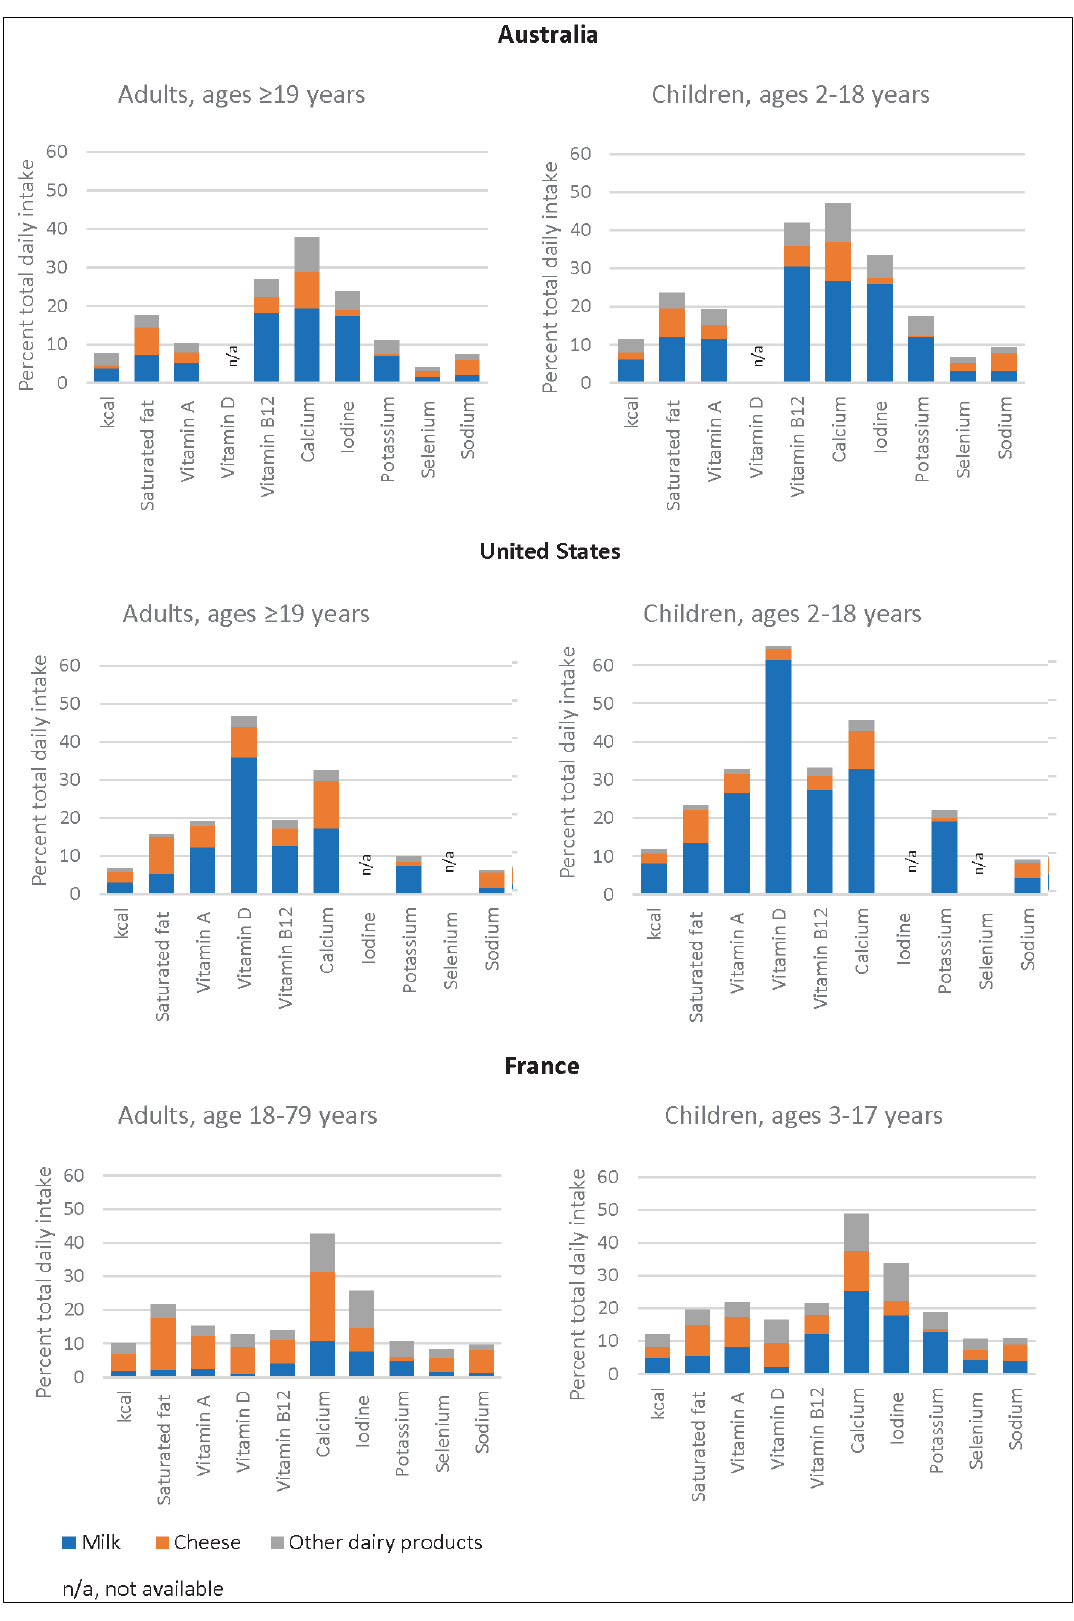
Figure 2. Contribution of milk, cheese and other dairy products consumed as individual foods to energy and selected nutrient intakes in children and adults in Australia, the United States and